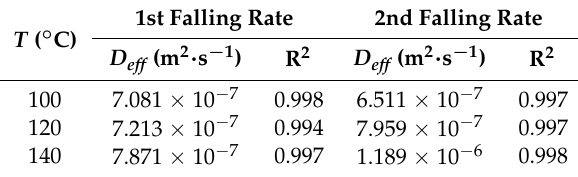
Figure 5. Plot of ln MR versus t of lignite at 100 ◦ C. ( a ) 1st falling rate period; ( b ) 2nd falling rate period. Table 6. Effective diffusion coefficient of lignite at different temperatures during microwave drying.